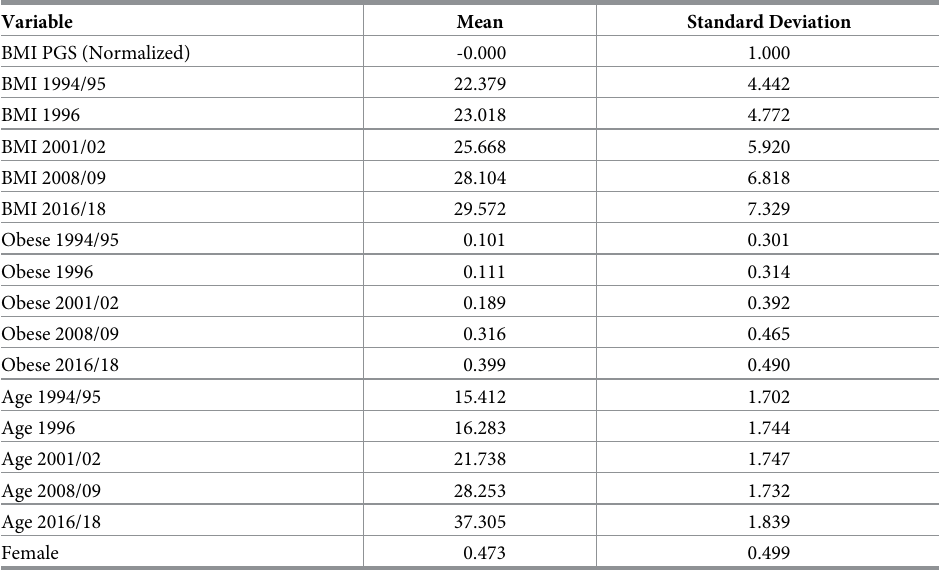
Table 2. Summary statistics. Add Health Sample.